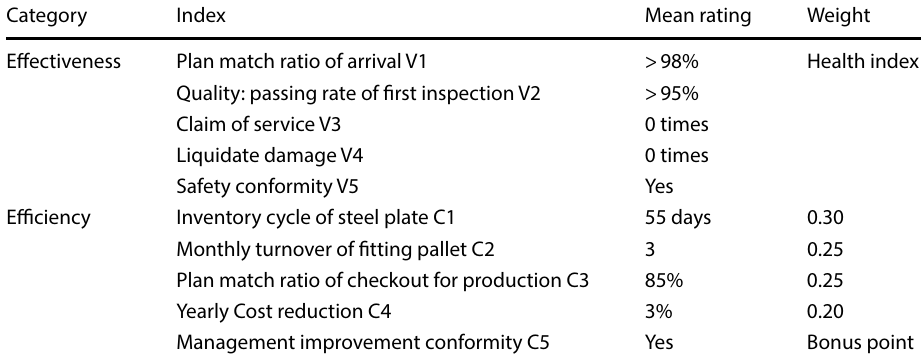
Table 1 Index of LSCM for Shipbuilding